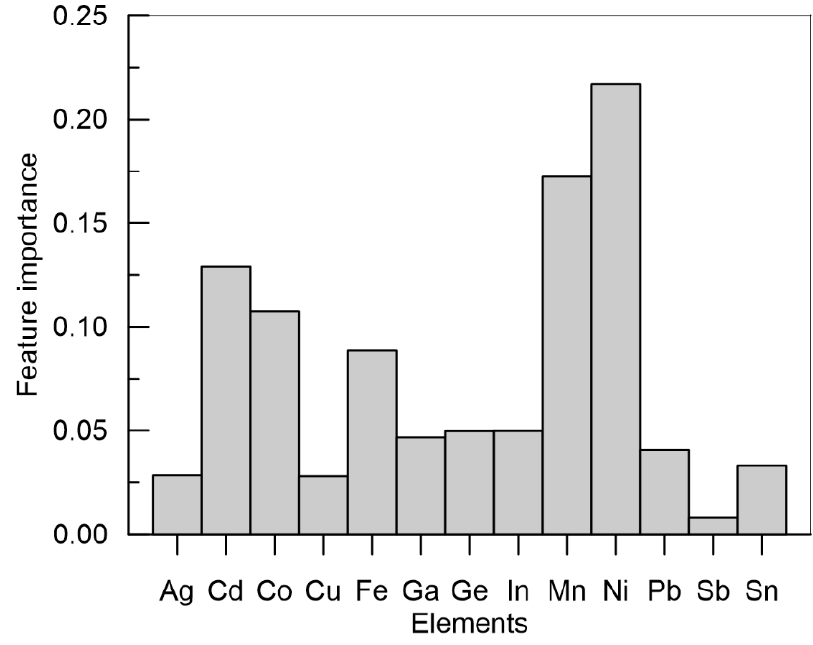
Figure 3. Feature importances of each element that was used in classifiers.